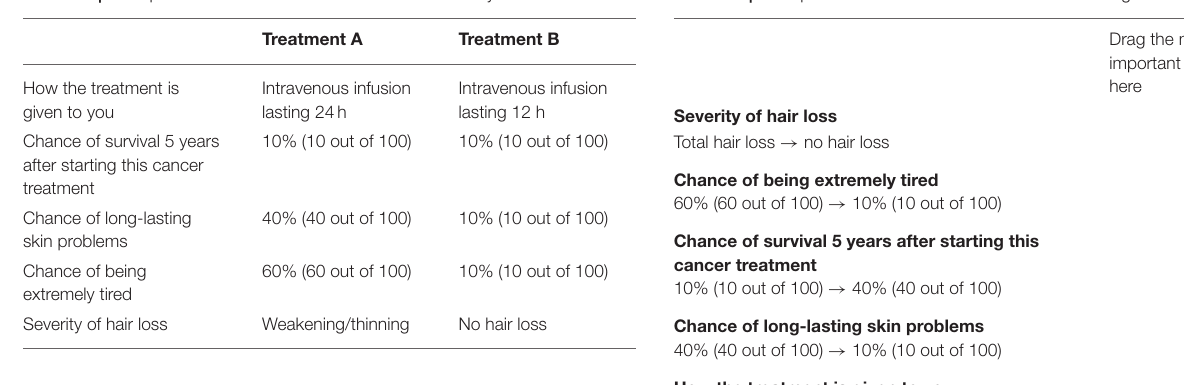
TABLE 3 | Example of a DCE choice task created for the study. TABLE 4 | Example of the SW choice task—attribute